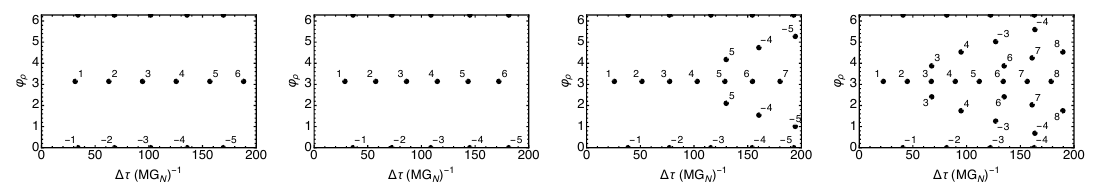
Figure 4 . Possible echos generated by bright point-like spots that are located in the photon shell of a black hole that is pierced by a cosmic string. The plots are given for a cosmic string that coincides with the black hole spin axis and has an orientation that corresponds to the + sign in (4.14). In these plots the observer inclination θ o is fixed to be θ o = 90 ◦ and the black hole spin parameter a varies. From left to right: a ( MG N ) − 1 = 0 . 1 , a ( MG N ) − 1 = 0 . 3 , a ( MG N ) − 1 = 0 . 5 , a ( MG N ) − 1 = 0 . 7 . The angular location ϕ ρ of the echos on the screen of an observer is plotted against the time interval ∆ τ after which the echos appear. The labels of the dots are the generated phases ∆Φ (2 πC ) − 1 that rotate the polarization direction of linear polarized photons of that particular echo. These are all integer numbers because the echos come from photons of the same point-like source that circle the black hole on closed orbits which implies that ∆ ϕ is an integer-multiple of 2 π (see (4.13), (3.11)).